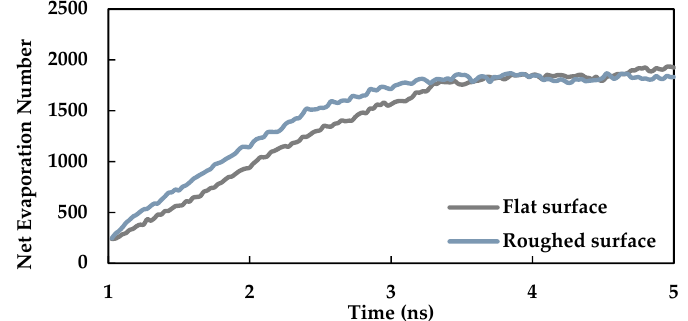
Figure 21. Net evaporation number as a function of time.